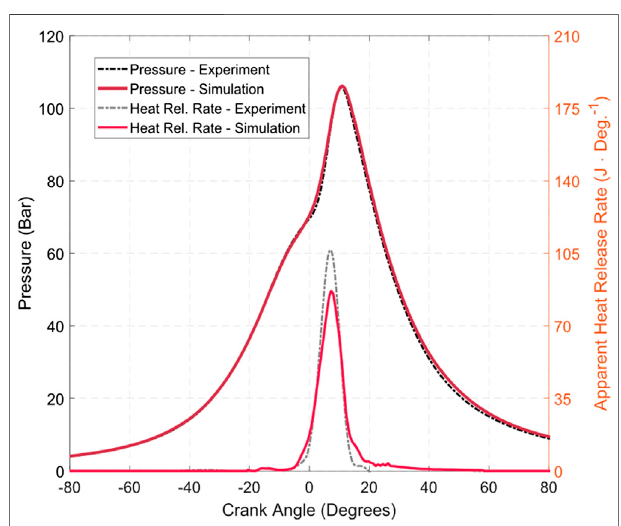
FIGURE 4 | Pressure and heat release rate curve comparison between simulation and experiment at cruise condition.